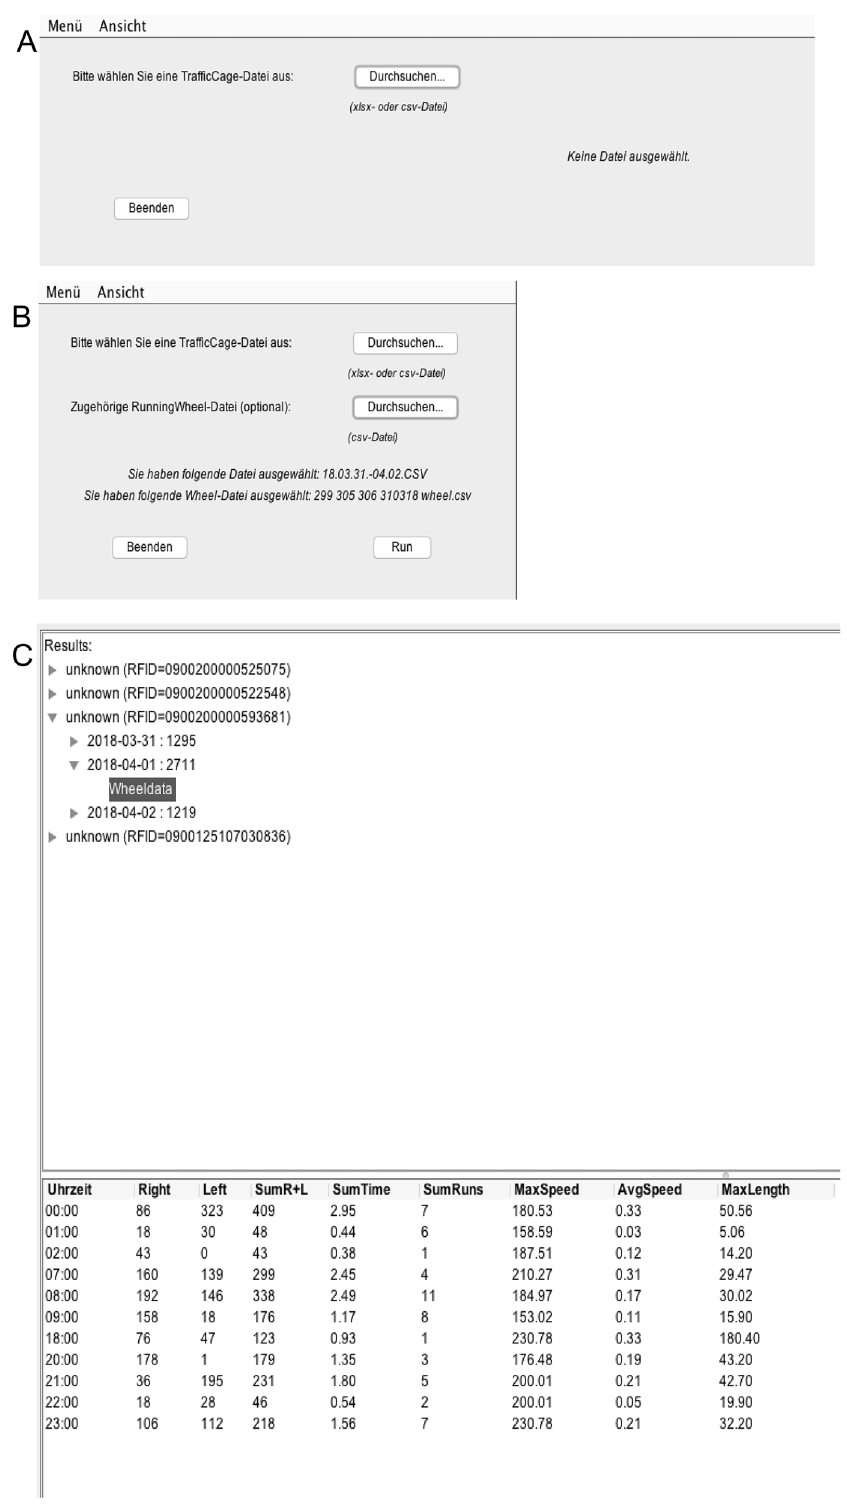
Figure 6. Overview of the SCAVE software (Version 2.0; Appendix 1). ( A ) Opening the software, the user can open a SCA file alone or in combination with the corresponding VE file, ( B ) both in cvs. format. By pressing “RUN” the software ( C ) calculates the results for each